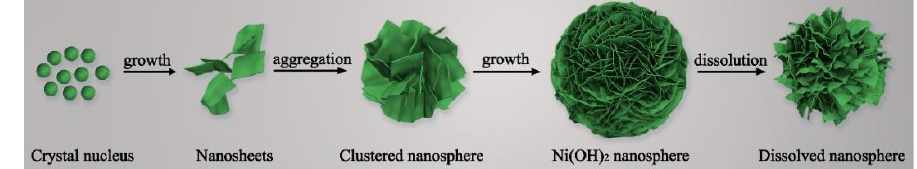
Figure 3. The formation mechanism of the 3D α -Ni(OH) 2 nanosphere.